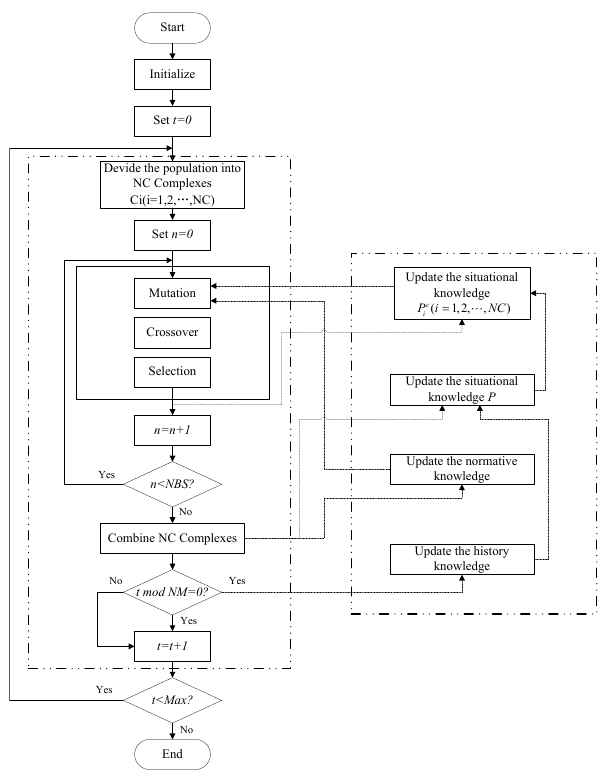
Fig. A1. Flowchart of Multi-objective Culture Shuffled Complex Differential